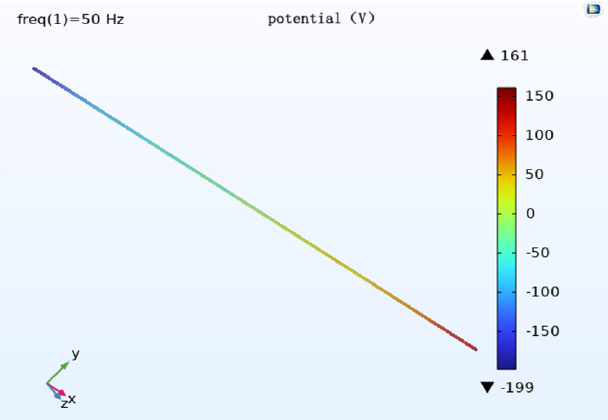
Figure 13. Distribution of cathodic protection potential when the parallel spacing is 0 m.